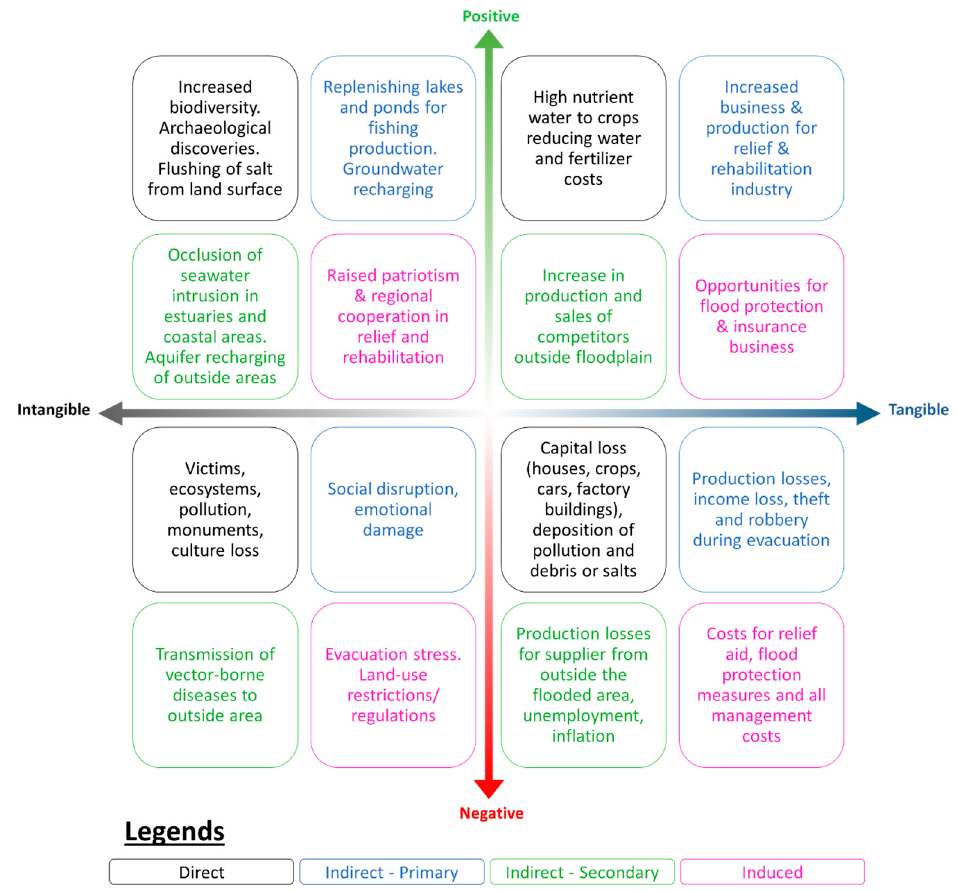
Figure 1. The classification of flood impacts in terms of Direct, Indirect-Primary, Indirect-Secondary, and Induced damages (this figure was developed based on the literature [20–25]).